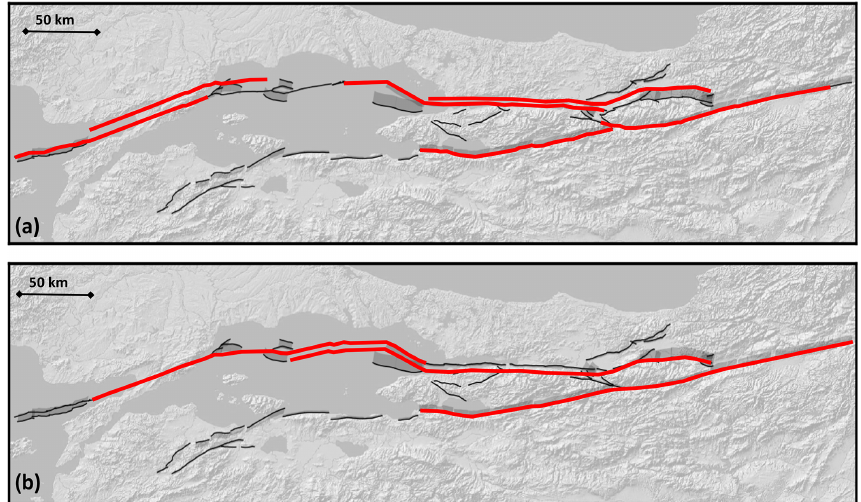
Figure 5. Example of the six largest ruptures included in the models using Set 1 (a) and the three largest ruptures included in the models using Set 2 (b) . Ruptures are stacked on top of each other for readability. The full list of ruptures is available in the electronic